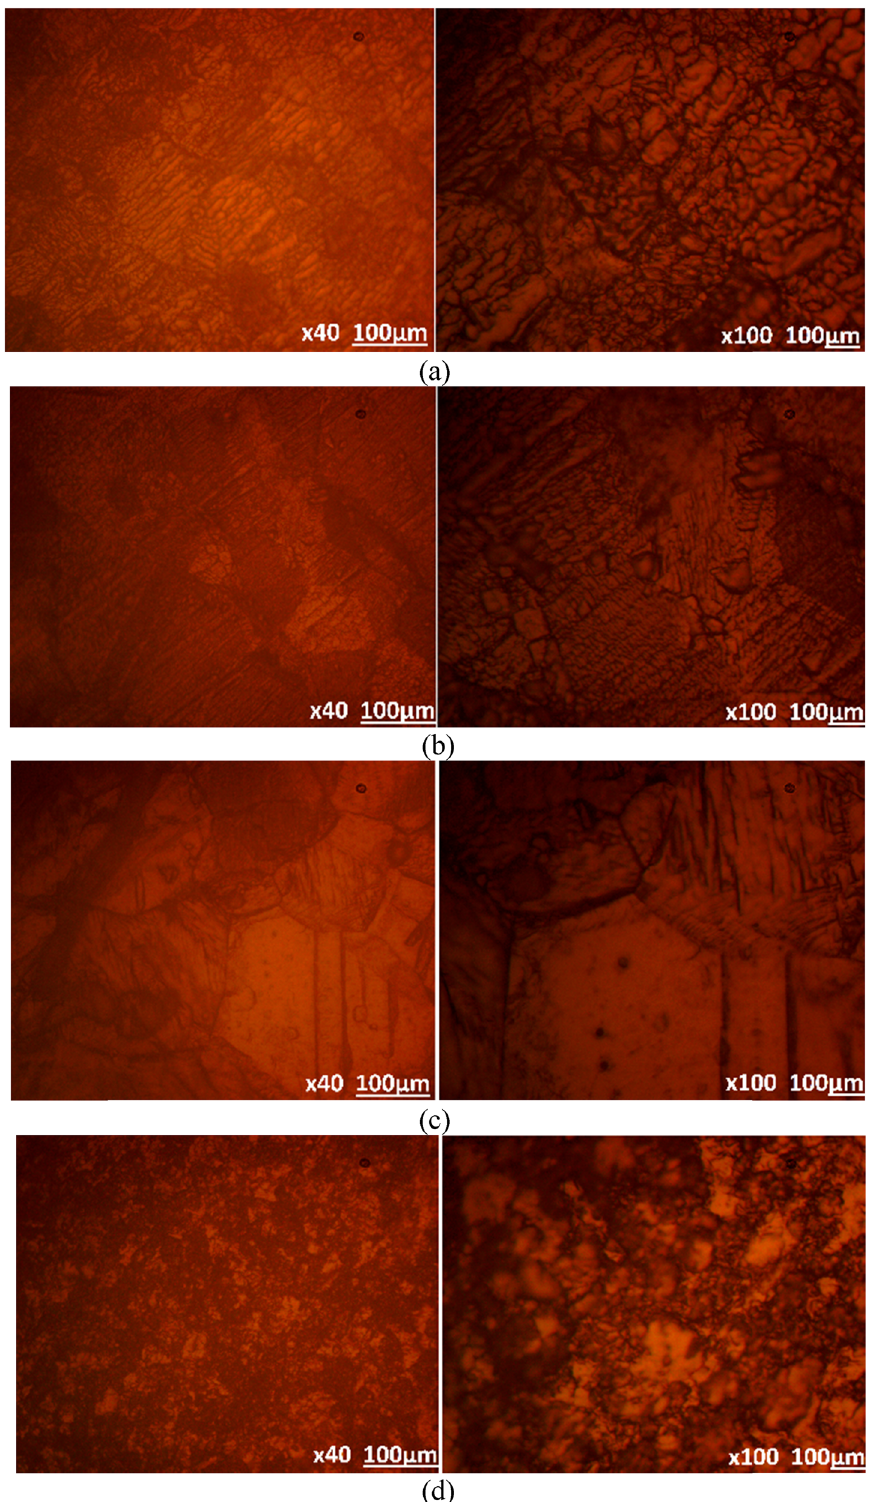
Figure 5: Optical morphology of ( a ) 439ll, ( b ) 316L, ( c ) NO7208, and ( d ) Ti6Al4V alloys following corrosion in 4 M H 2 SO 4 + 5% NaCl solution at